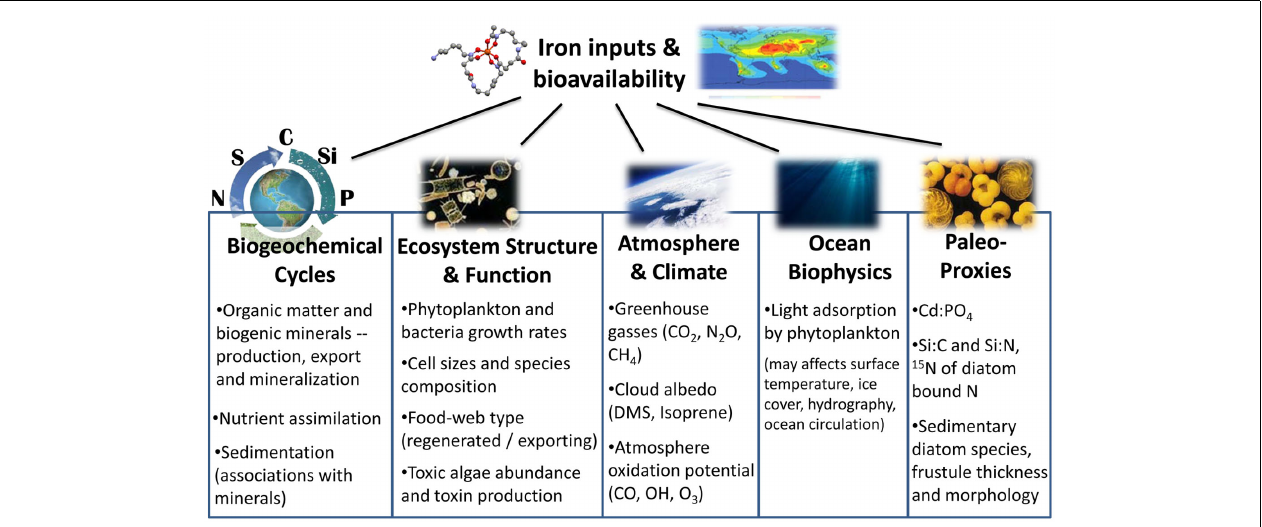
FIGURE 2 | Summary of processes, systems, and research fields which are influenced by iron inputs and bioavailability (see text for